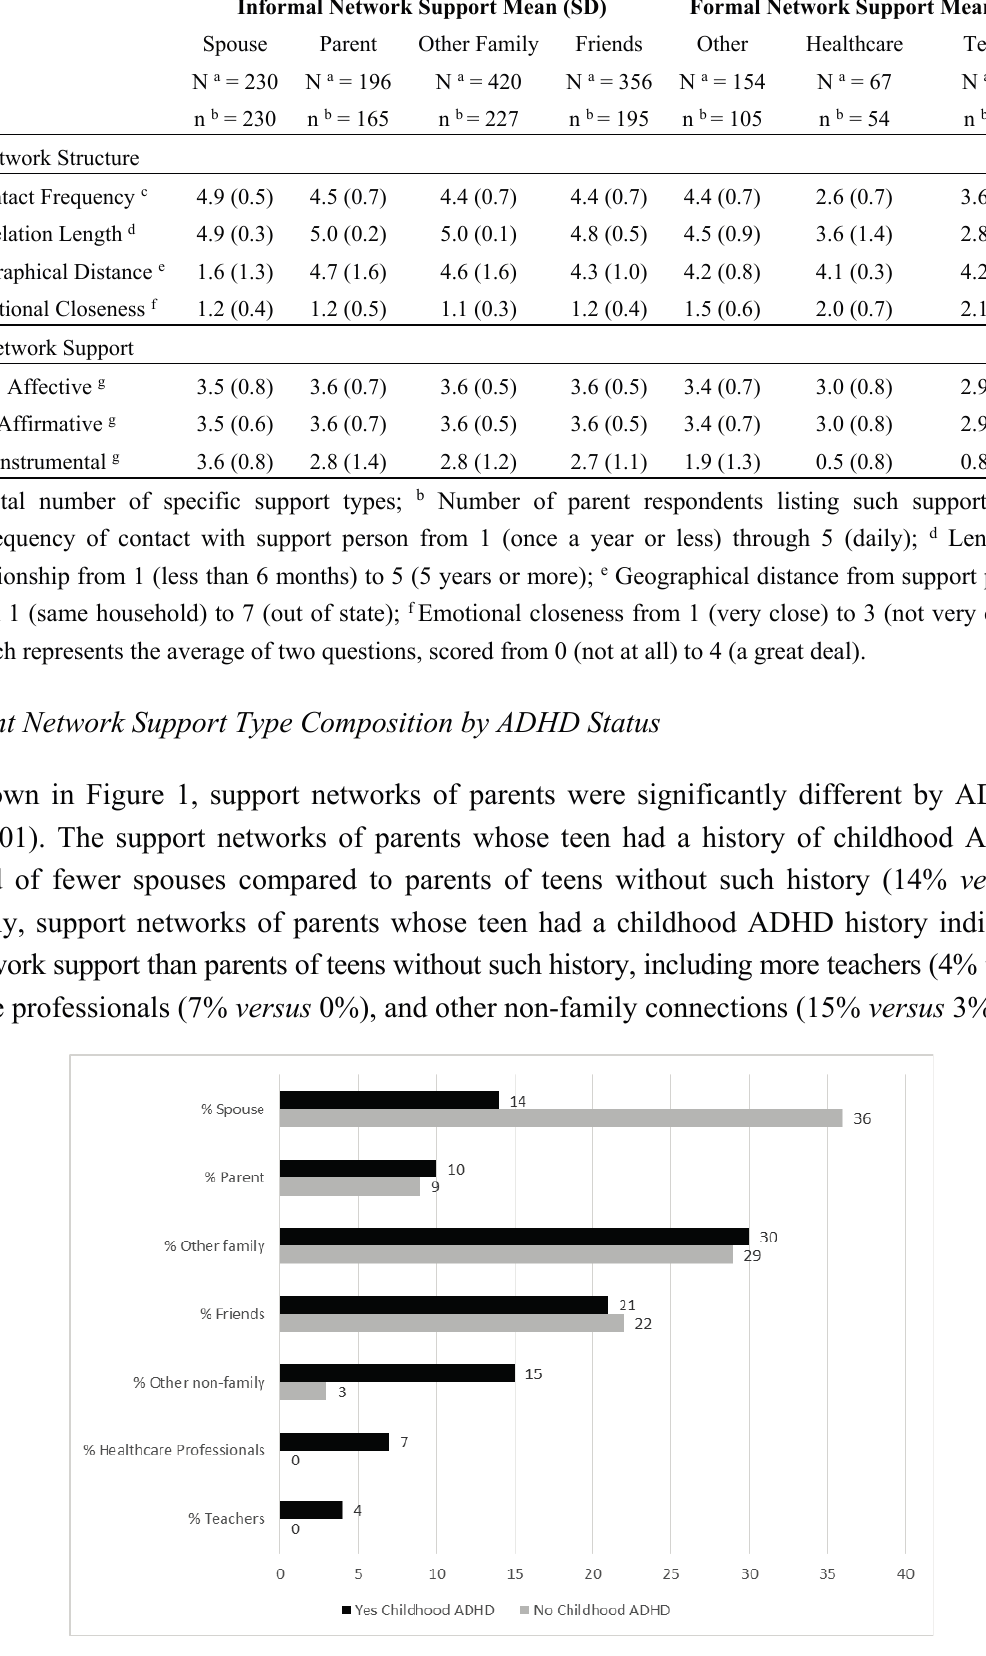
Table 1. Parent network structure and support levels by type of support source. Informal Network Support Mean (SD)